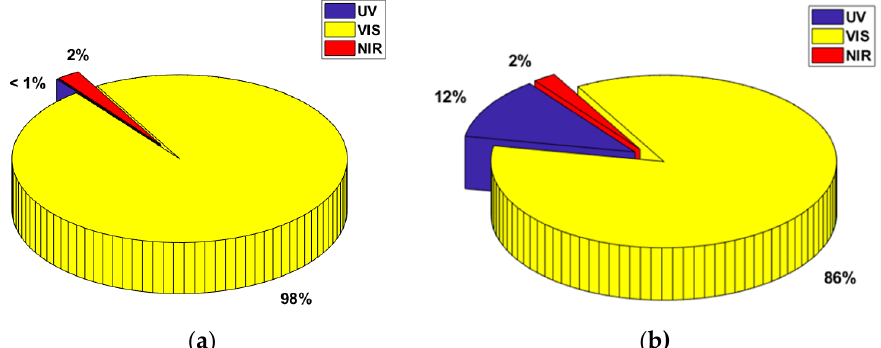
Figure 7. Percentage of optical radiation energy for electrical discharges generated in natural ester, Midel 7131, on electrode systems: needle–needle ( a ) and for surface discharges ( b ).